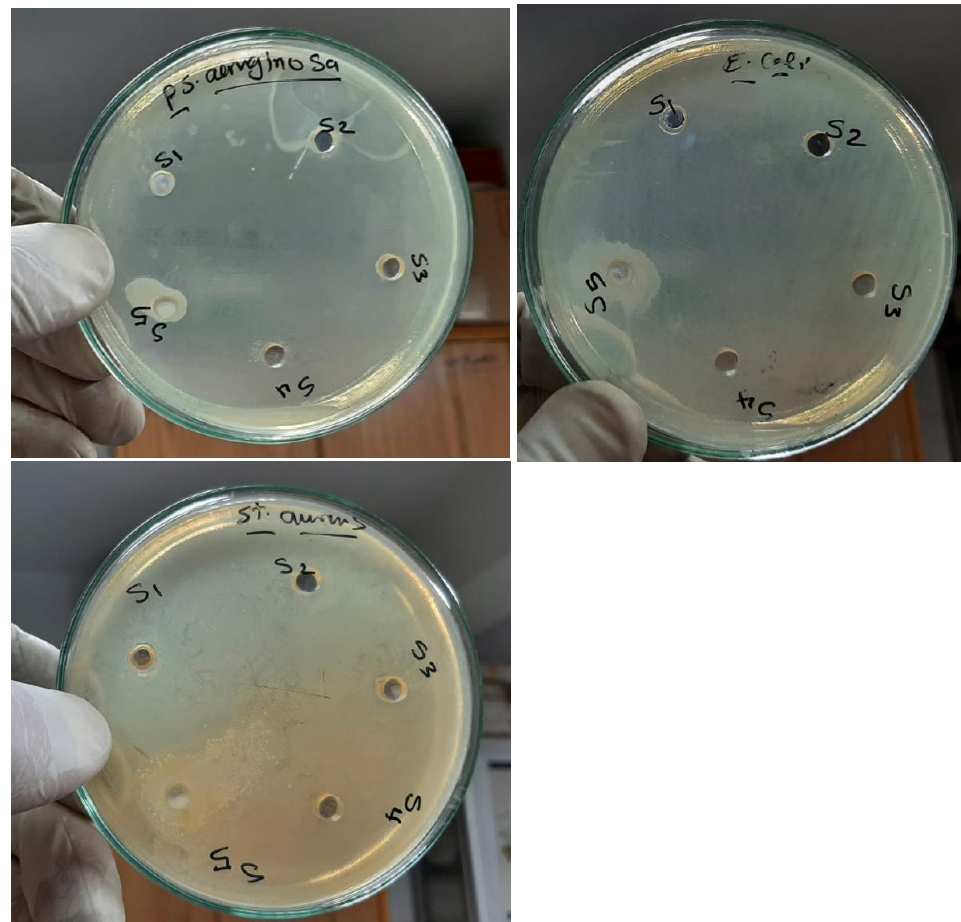
Figure 10. Antibacterial inhibition zones of the PEO/CMC composite with a differing content of TiO 2 NPs: (S 1 ) PEO/CMC, (S 2 ) 0.10, (S 3 ) 0.20, (S 4 ) 0.40, and (S 5 ) 0.80 wt. % TiO 2